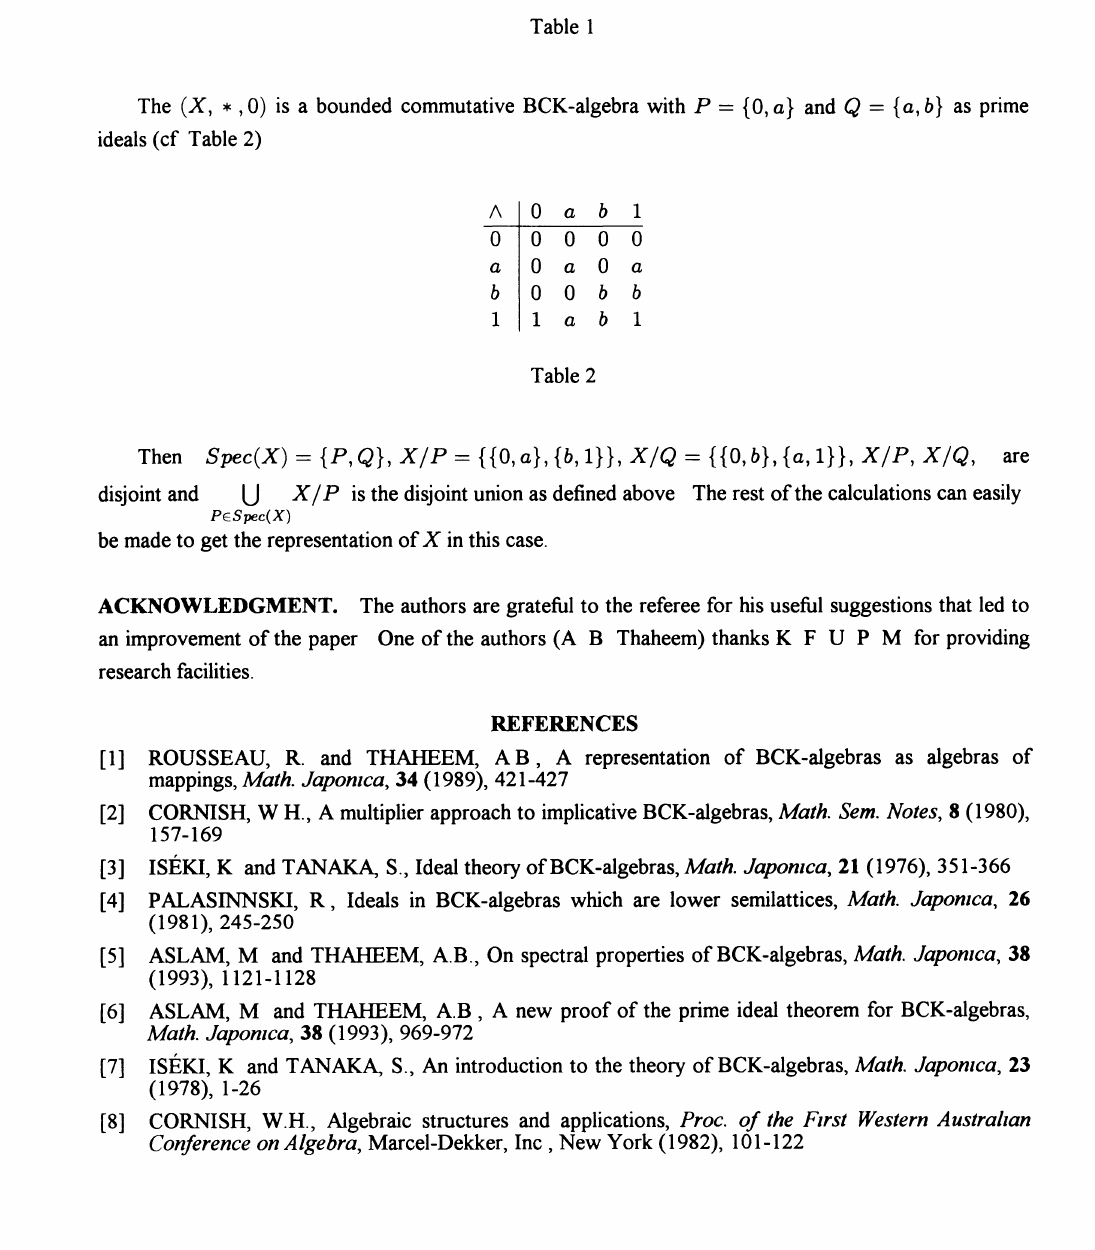
,, 0) is a bounded commutative BCK-algebra with The (X,